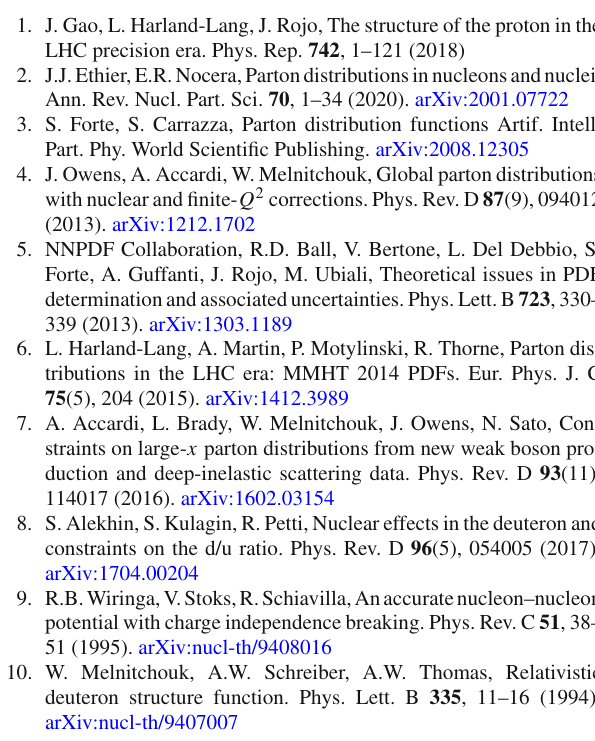
Fig. 9 Distances between the central values of the global-base and global-ite2-dw fits (left) and of the global-base and global-ite2-sh fits (right), see Table 1 for details. Results are displayed as a function of